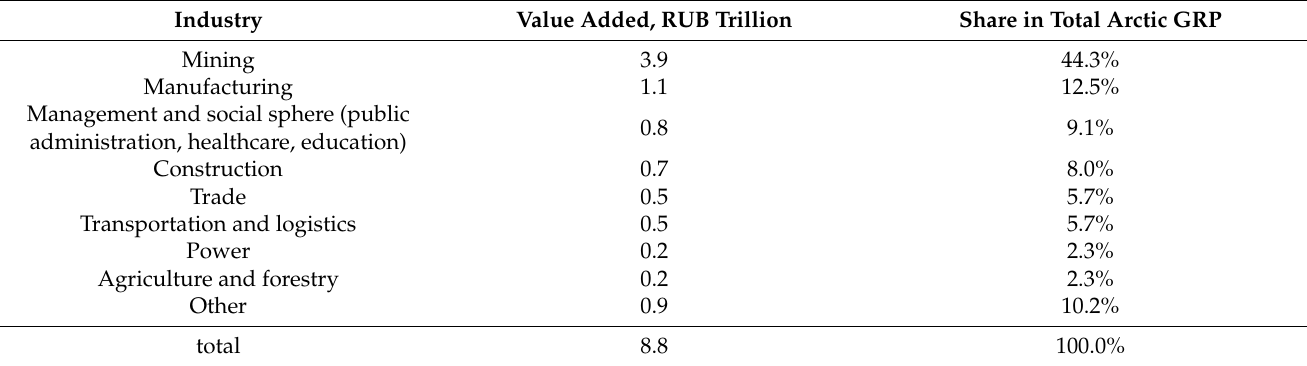
Table 2. The main industries of the AZRF region.